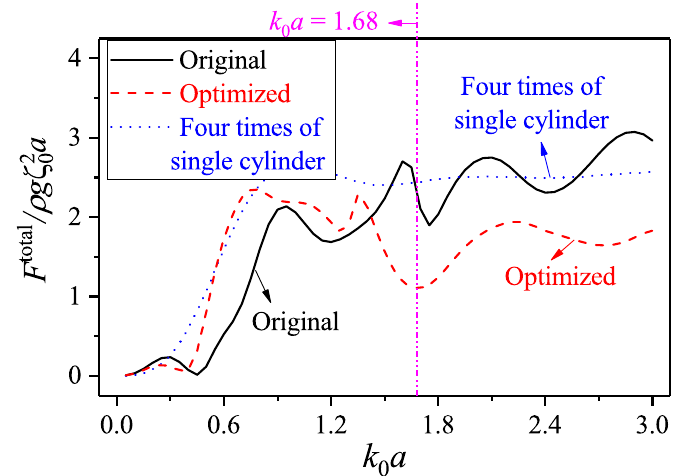
Figure 14. The total wave drift forces on the original structure, optimized structure and four times of single